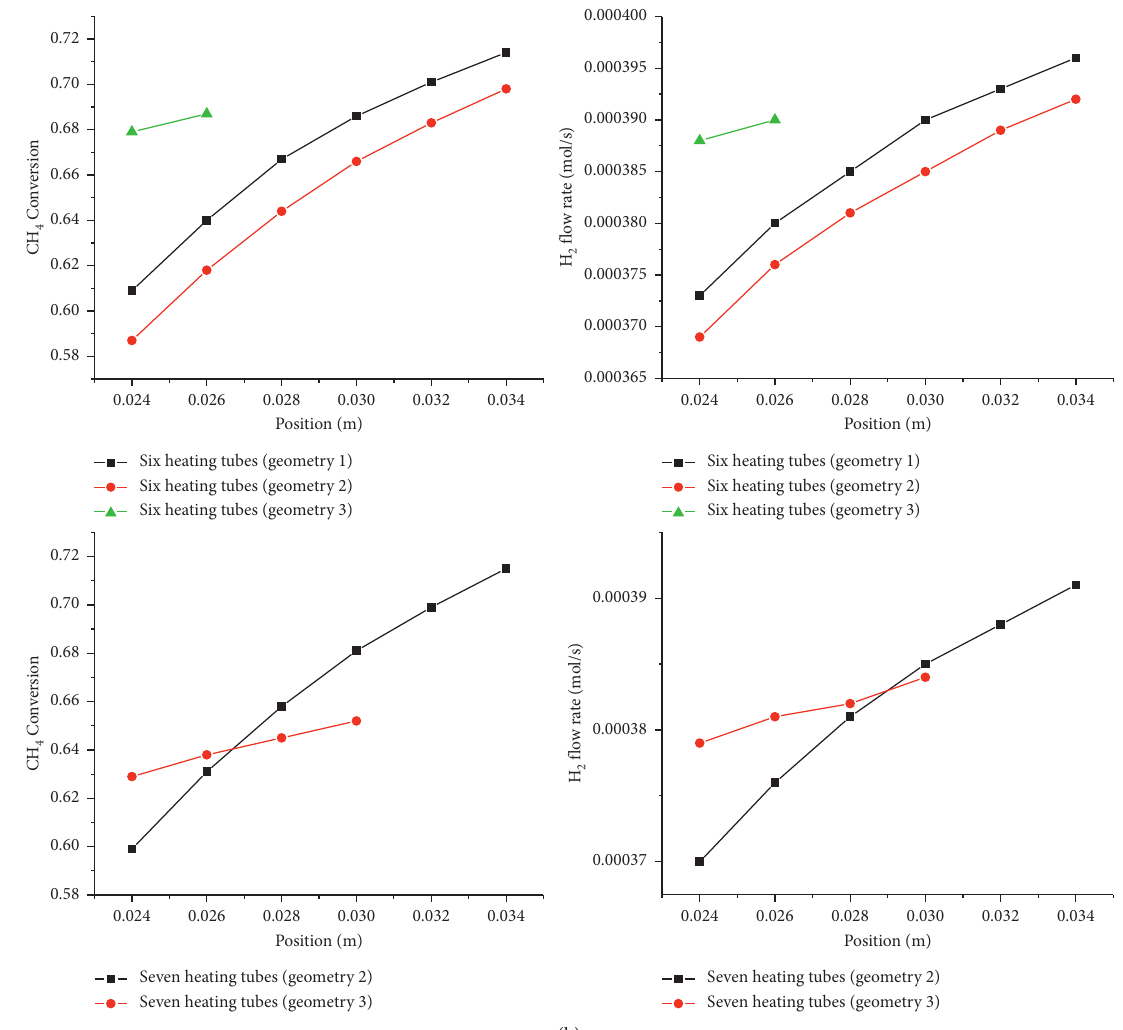
Figure 7: CH4 conversion and H2 flow rates with varying the number of heating tubes: the number of heating tubes increases from top to bottom (4, 5, 6, and 7) for each